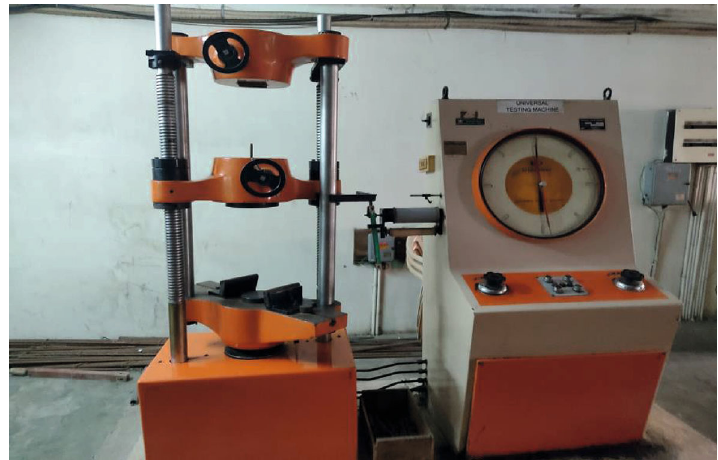
Figure 2: Photographic view of tensile testing machine.